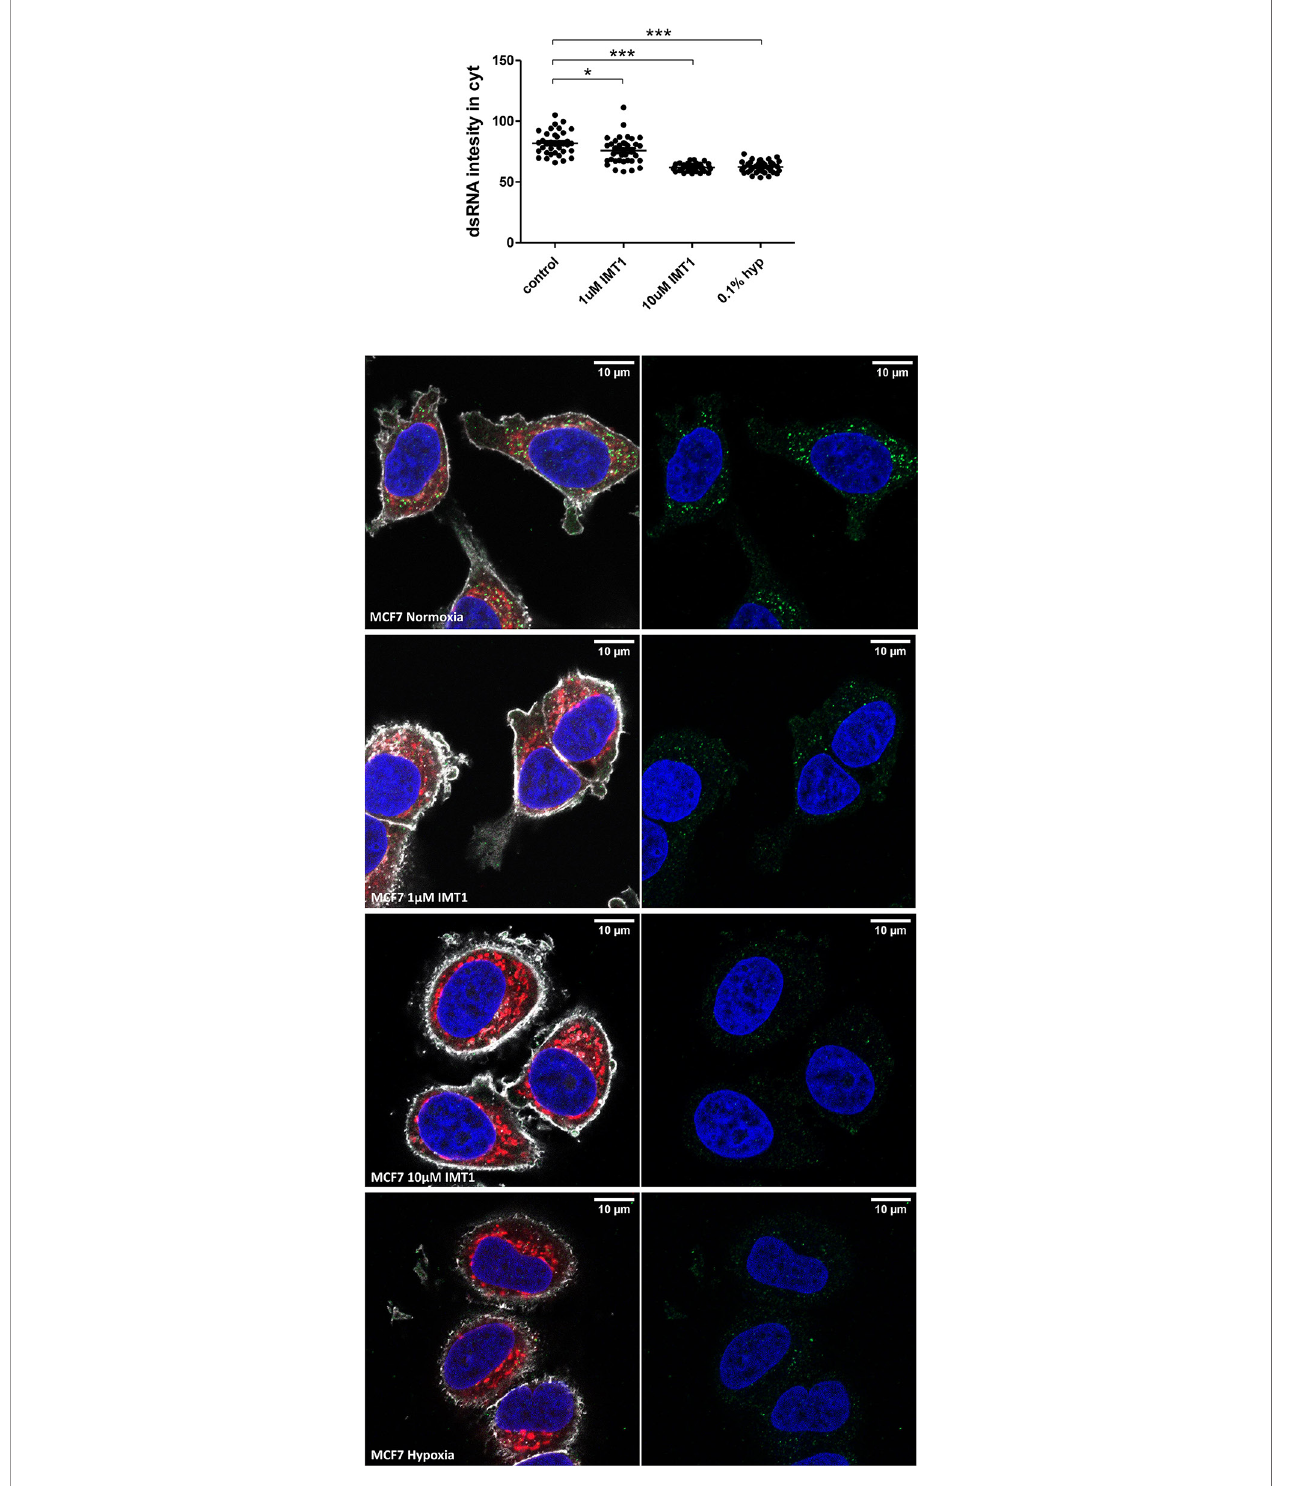
FIGURE 6 | IMT1 reduces dsRNA staining. dsRNA was stained using J2 antibody in MCF7 cells exposed to normoxia (n=36 cells), treated with 1µM IMT1 (n=36 cells), treated with 10µM IMT1 (n=36 cells) or exposed to 0.1% hypoxia (n=36 cells) for 48h from 3 independent replicates. Data is shown as mean ± SEM. *p < 0.05, ***p < 0.001. Green: J2 antibody staining, blue: DAPI, and red: MitoTracker staining. Scale bars correspond to 10 m m.